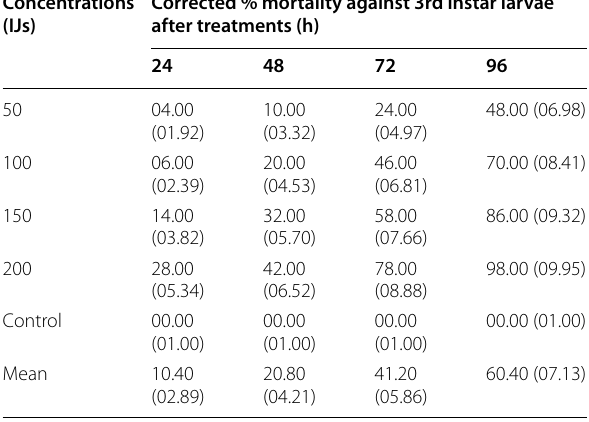
Table 7 Potential of Heterorhabditis bacteriophora bassiana against 3rd instar larvae of Spodoptera litura under laboratory conditions